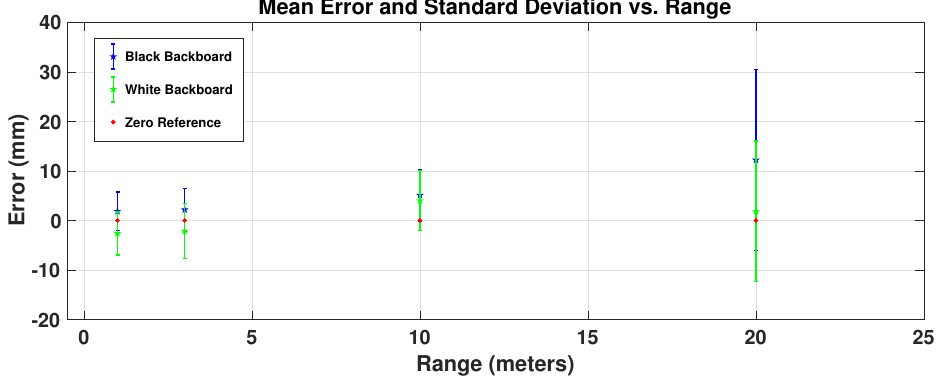
Figure 6. Means of 10,000 measurements at ranges between 1 m and 20